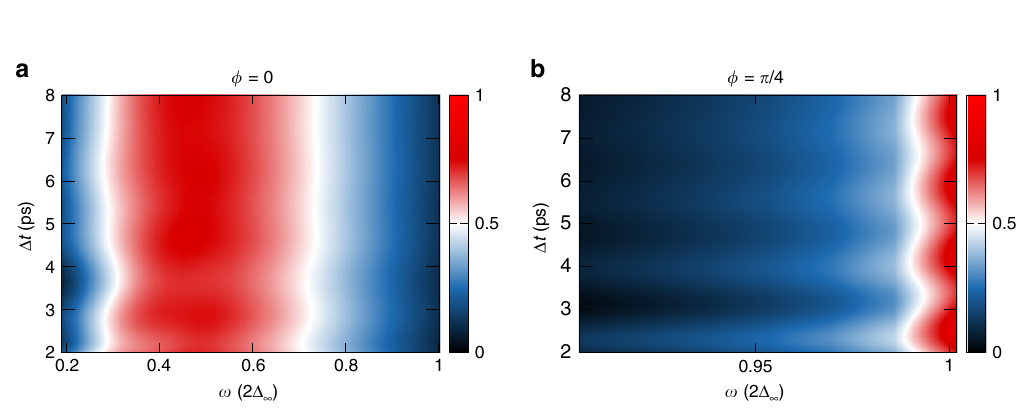
Fig. 4 Optical conductivity of a d - wave superconductor after excitation with a quench pulse . Real part of the optical conductivity Re σ ð Δ t ; ω Þ after a ¼ 0 : 4 ps, j A j = 7 ´ 10 (cid:1) 8 realistic quench pulse for incident angles a ϕ ¼ 0 and b ϕ ¼ π = 4 for a d x 2 (cid:1) y 2 -wave superconductor. The pulse parameters are τ p p ¼ 0 : 25 ps, j A j = 1 ´ 10 (cid:1) 8 Js C (cid:1) 1 m (cid:1) 1 and _ ω ¼ 2 : 5 meV for the probe pulse. The gap value in the Js C (cid:1) 1 m (cid:1) 1 and _ ω ¼ 3 meV for the quench pulse and τ p p simulation is 2 Δ ¼ 2 : 7 meV. The vertical axis denotes the time delay between the excitation of the system with the quench pulse and the probe pulse. The horizontal axis denotes frequency ω . The oscillation frequencies in Δ t correspond to the frequencies of the Higgs modes as shown in Supplementary Fig. oscillation symmetries of the condensate depending on the incident angle.